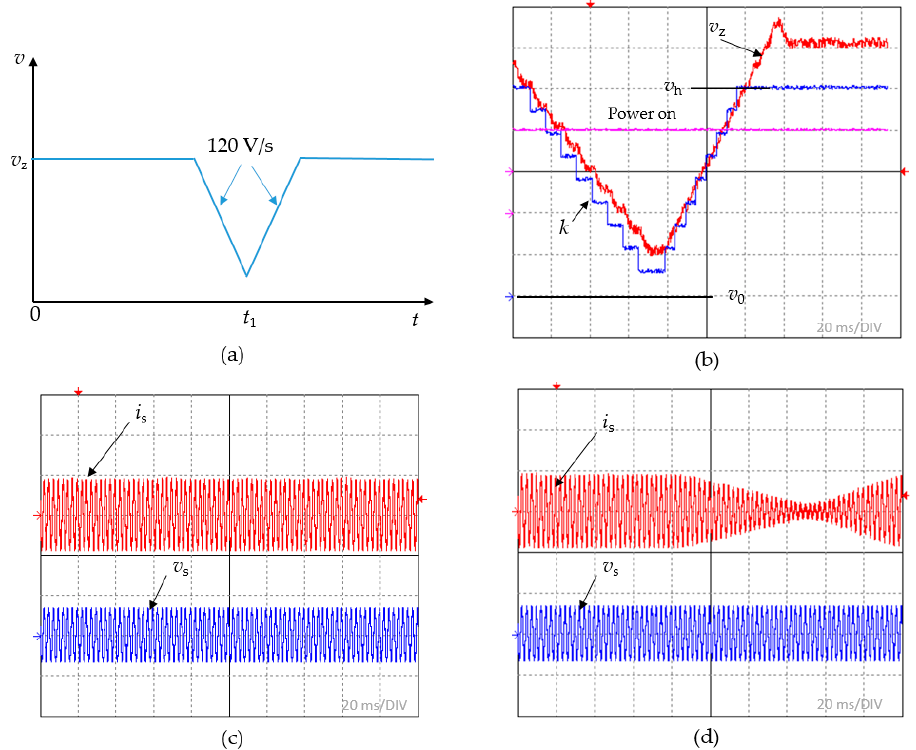
Figure 9. Dynamic response of the system to a voltage change on power bus 4: ( a ) assumed voltage profile on bus 4; ( b ) waveforms of the recorded voltage of bus 4 v z , correction factor k, and supply voltage identifier (pink color); waveforms of current i s and voltage vs. of bus 2 recorded in the classical system ( c ) and in the proposed system ( d